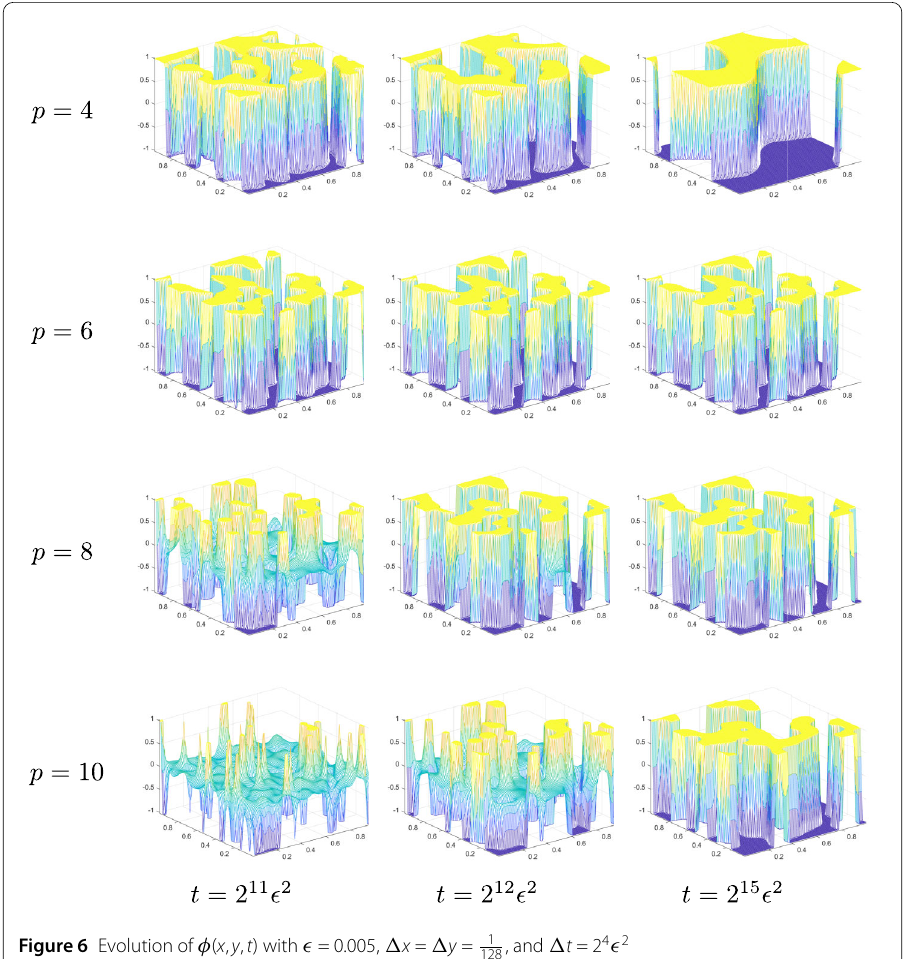
Figure 6 Evolution of φ ( x , y , t ) with (cid:4) = 0.005, (cid:7) x = (cid:7) y = 1